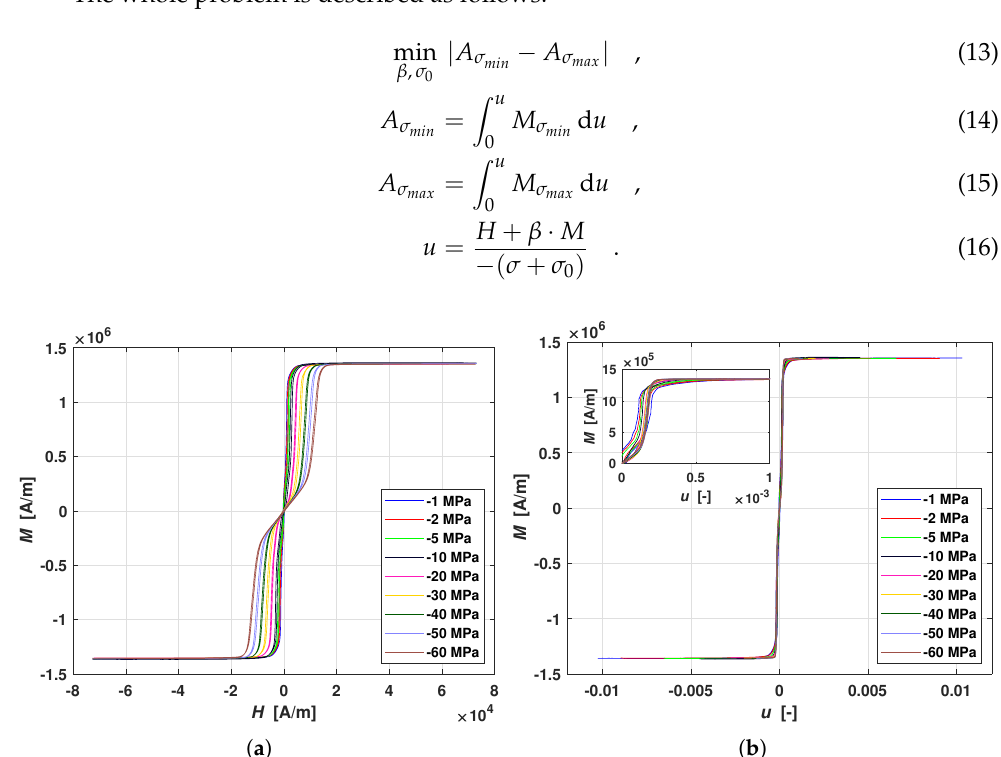
Figure 4. Magnetic characteristics ( M - H ) at different applied compressive stresses σ ( a ) and graphical representation of the self-similarity property ( b ) for NSA Galfenol. The inset represents a zoom of the figure in the 0–0.001 range of u . It is possible to note how the M - u curves almost collapse into a single one, where u is defined as in Equation (16) with the parameters obtained from the minimization